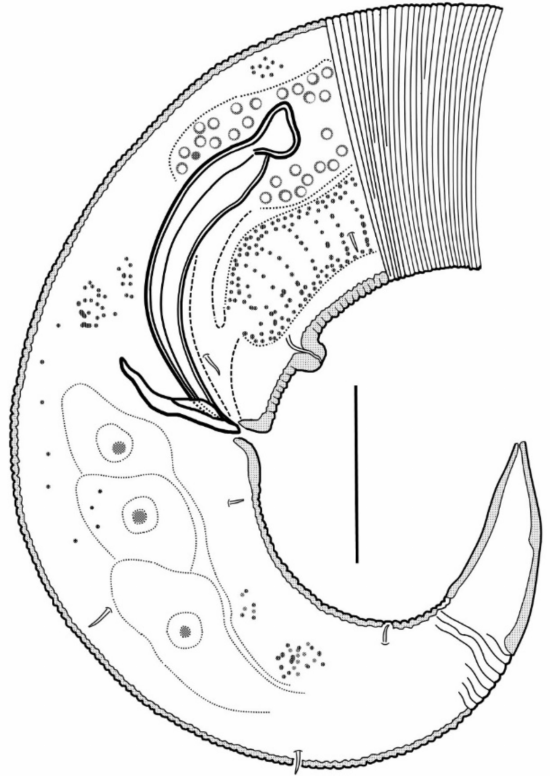
Figure 13. Acanthopharynx parva sp. n., holotype male tail. Scale bar 20 µ